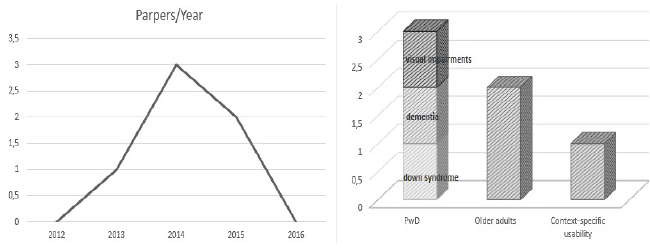
Fig. 2. UAIS papers per year and issues addressed The design for users with visual impairments is a key aspect to be considered in universal and participatory